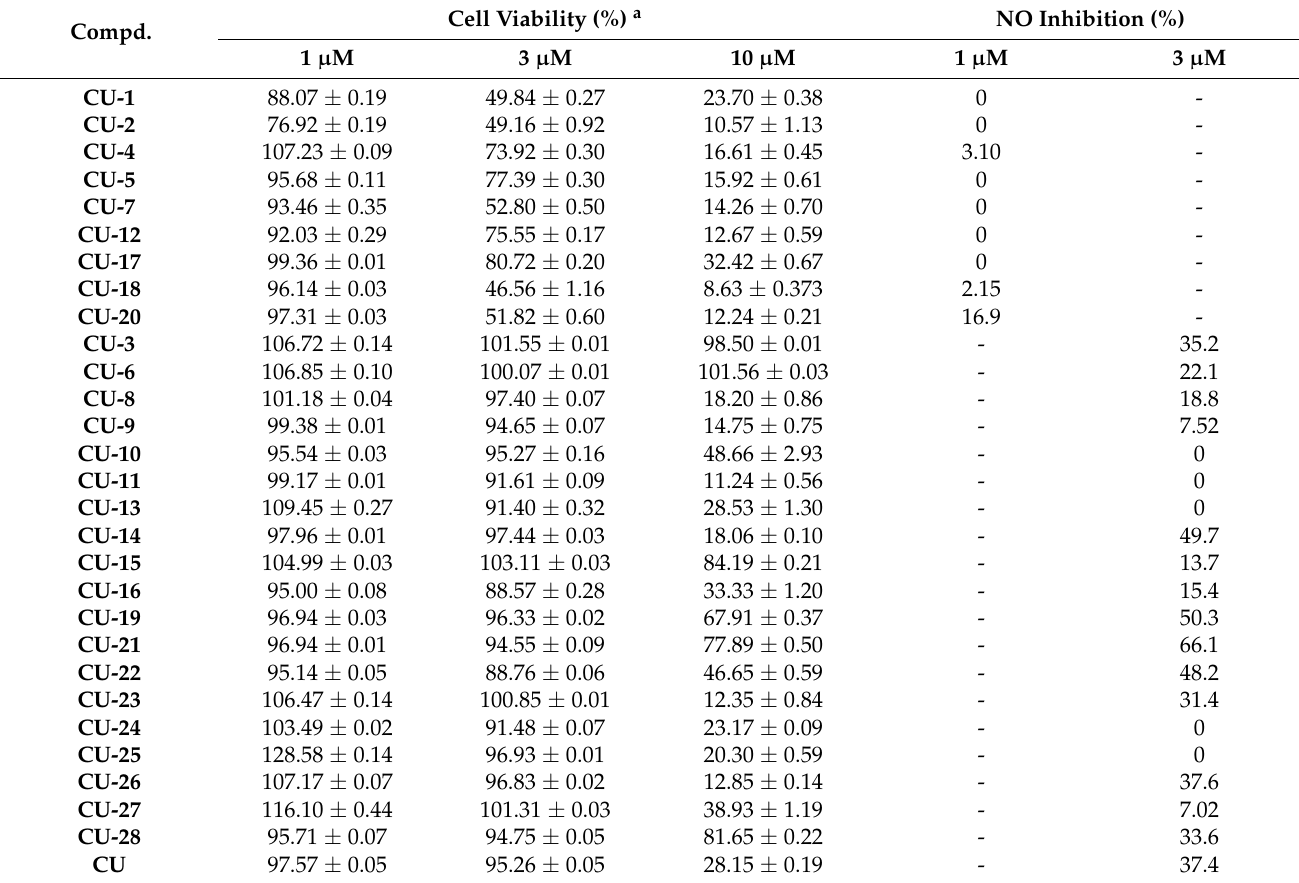
Table 2. The cell viability and inhibition of LPS-induced NO release in BV2 cells.